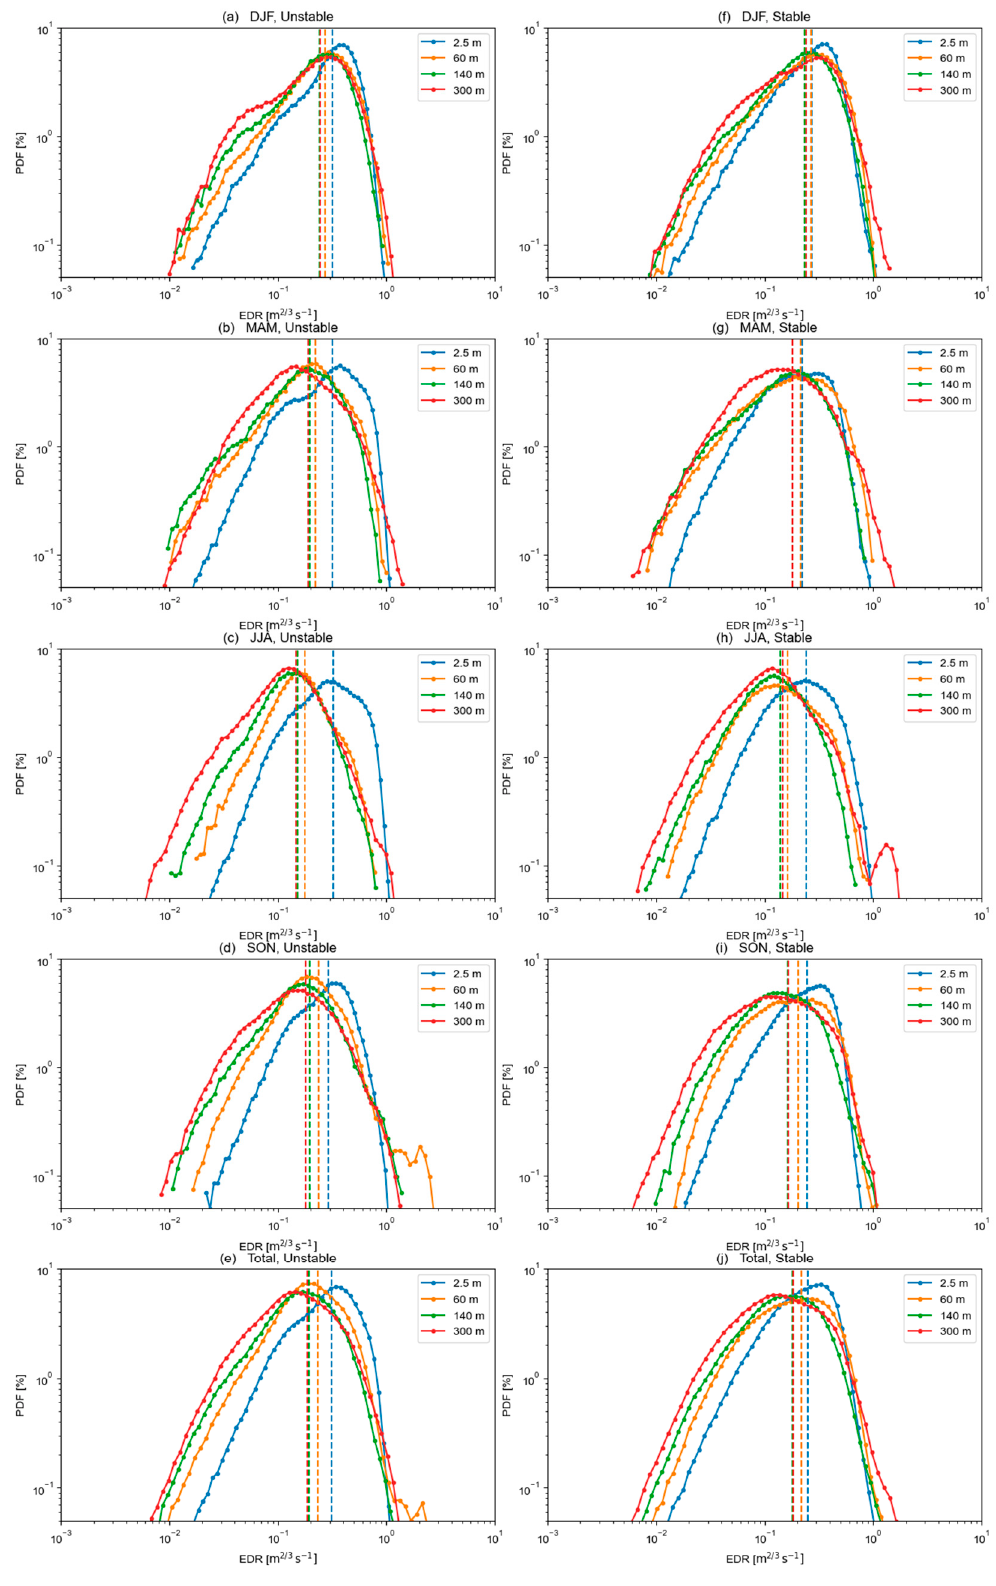
Figure 8. PDFs of EDR. Left panel shows the PDFs for the unstable PBL in ( a ) DJF, ( b ) MAM, ( c ) JJA, ( d ) SON, and ( e ) total in 2018, and for the stable PBL in ( f ) DJF, ( g ) MAM, ( h ) JJA, and ( i ) SON, and ( j ) total in 2018, at 2.5 m (blue solid line), 60 m (orange solid line), 140 m (green solid line), and 300 m (red solid line). Dashed line indicates mean of EDR1 in the given season at the given level.